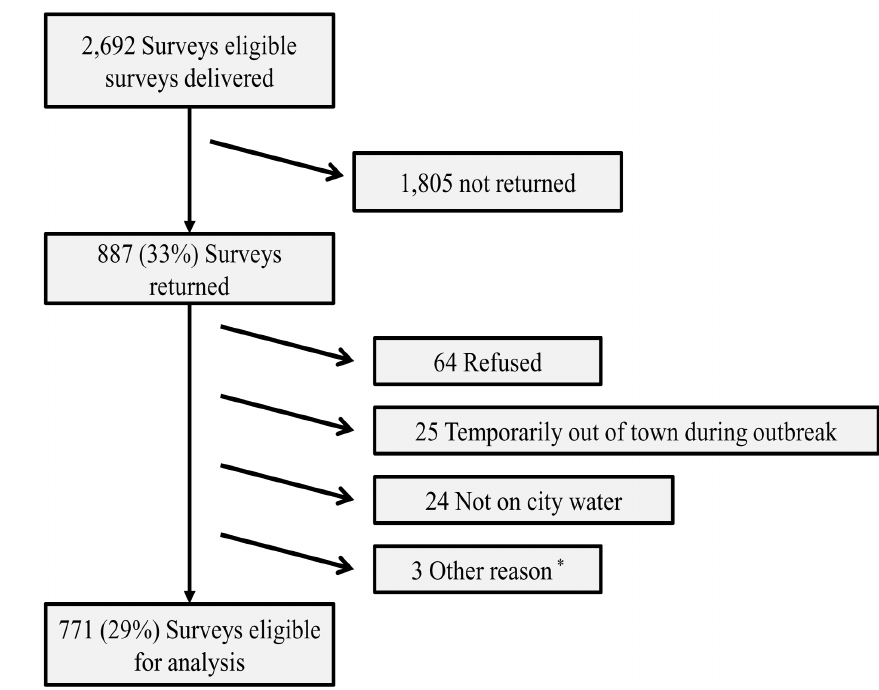
Figure 1. Household survey response rate.